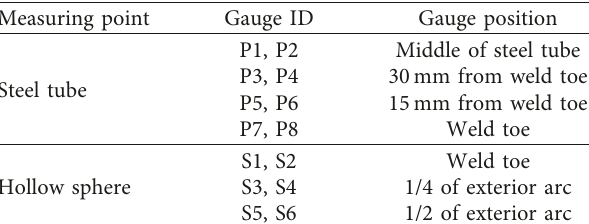
Figure 4: Typical gauge arrangement. Table 2: Gauge position and its